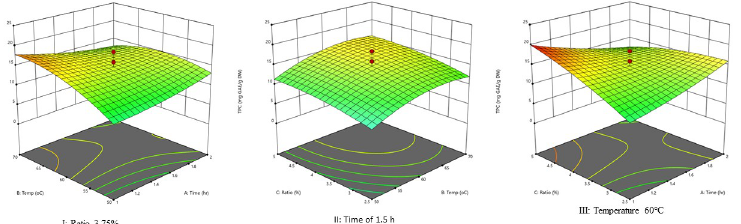
Fig 4. Response surface plots. The response surface plot I show the interactions of extraction temperature and time at a fixed solvent-to-solid ratio on total polyphenols, the response surface plot II indicates the interaction effects of solid- to-solvent ratios and temperature at a constant time on extraction efficiency of total polyphenols, and the plot III indicate the interaction of time and solvent-to-solid ratios at a fixed temperature at 60˚C.